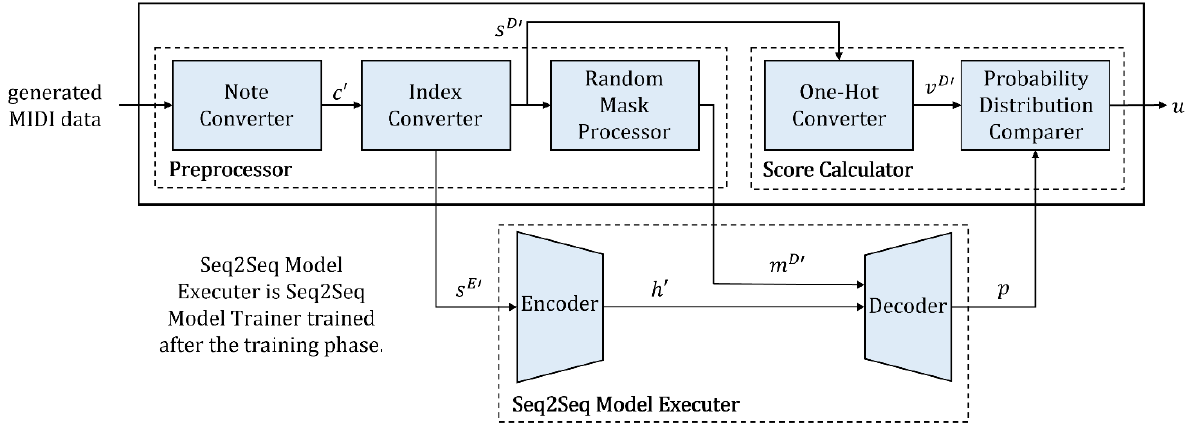
Figure 2. Execution phase of the enhanced evaluation method.